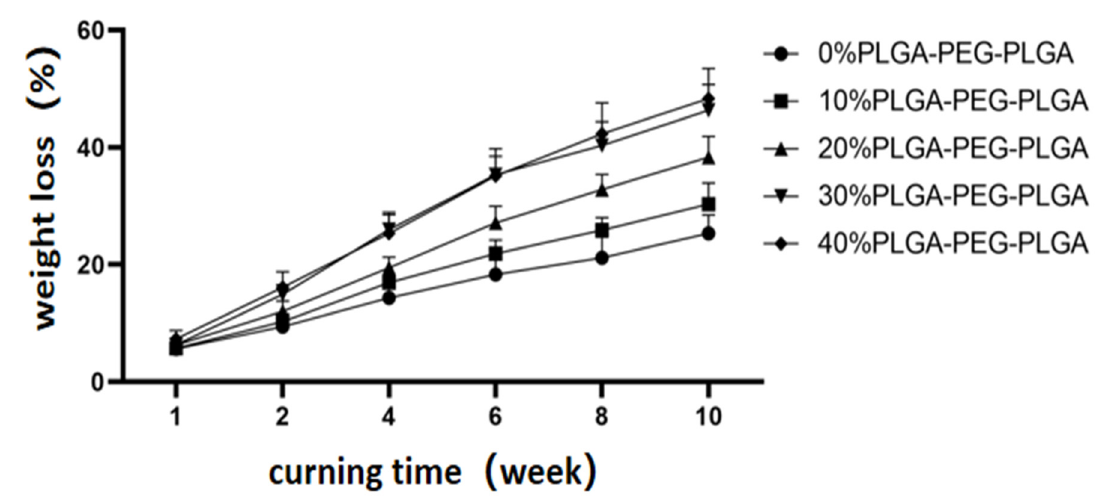
Figure 8. Degradation of the composite bone cements with different PLGA–PEG–PLGA temperature-sensitive hydrogel contents with curing time.